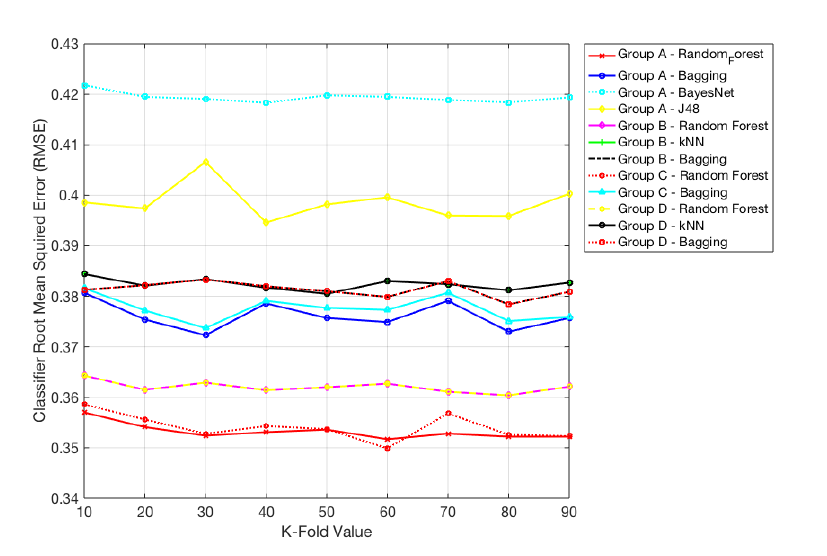
Figure 2. Root-mean-square error (RMSE) values <0.42 for different classifiers.